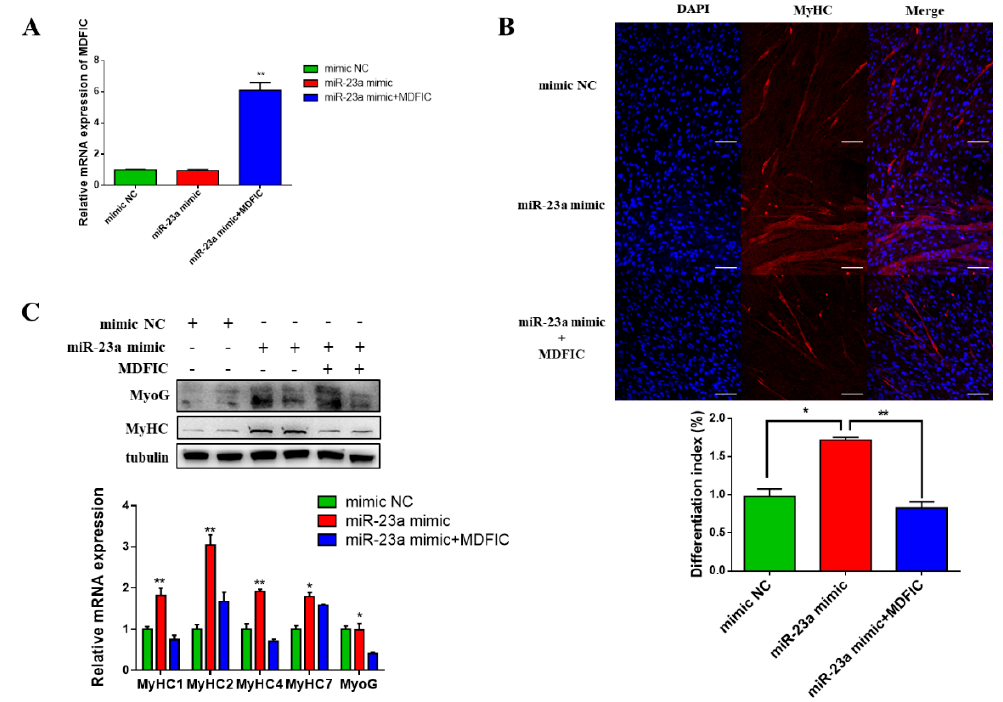
Figure 6. Overexpression of MDFIC rescues the miR-23a-induced effects. ( A ) The mRNA levels of MDFIC in PDGFR α− bPCs transfected with mimic NC, miR-23a mimic or miR-23a mimic+MDFIC. ( B ) MyHC (red) positive cells of MD after transfection with mimic NC, miR-23a mimic or miR-23a mimic + MDFIC. Scale bar represents 100 μ m. Differentiation index of myoblast after transfection with mimic NC, miR-23a mimic or miR-23a mimic + MDFIC. ( C ) The protein and mRNA expression levels of MyHC and MyoG in PDGFR α− bPCs transfected with mimic NC, miR-23a mimic or miR-23a mimic+MDFIC. β -tubulin was used as the reference gene. Results are representative of the mean (± SD) of three independent analyses. * p < 0.05, ** p < 0.01.